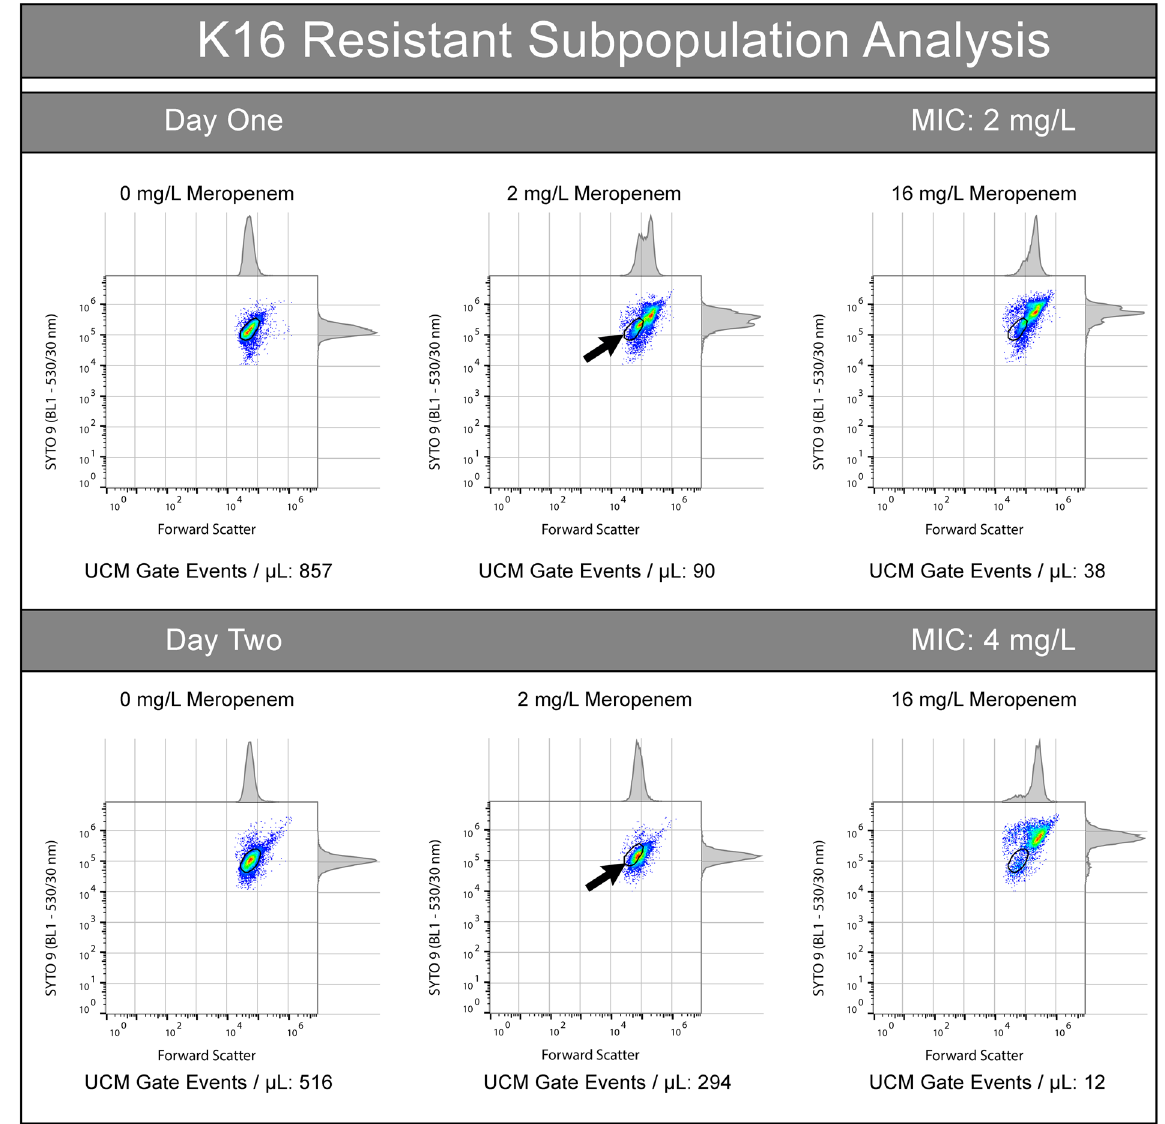
Figure 6. Resistant sub-populations were observed in K. pneumoniae isolate K16 across two days of selective passage and FAST: Day One - IMP-4 producing K. pneumoniae isolate K16 was found, at 2 mg/L meropenem, to contain a minority population of cells with a phenotype consistent with unexposed cells (remaining within the Unexposed Cell Morphotype gate - indicated by arrow). This subpopulation persisted, at a diminished frequency, at 16 mg/L meropenem while the majority of cells display a compromised phenotype (shifted outside the gate). Day 2 – The 2 mg/L culture of K16 from Day 1 was subcultured and subjected to FAST on the following day. The isolate displayed an increased MIC (4 mg/L), delayed progression to the emergence susceptibility-associated signature, with most events consistent with a non-susceptible phenotype at 2 mg/L. Most events at 16 mg/L were consistent with a susceptible phenotype, however a small subpopulation remained inside the Unexposed Cell Morphotype